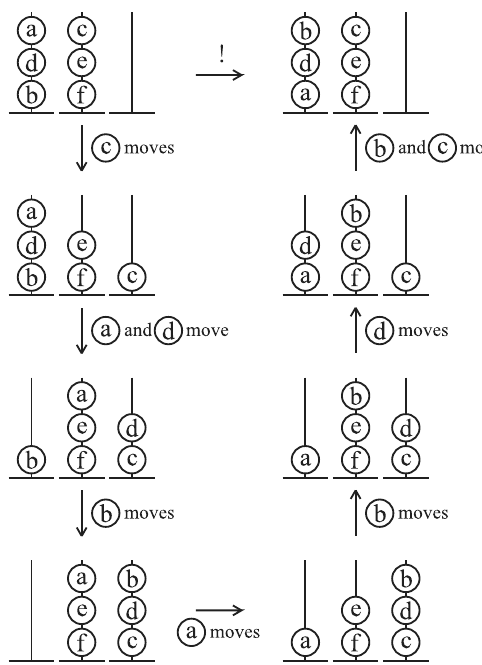
Fig. 6. Example for interchanging two balls on one peg in the proof of the